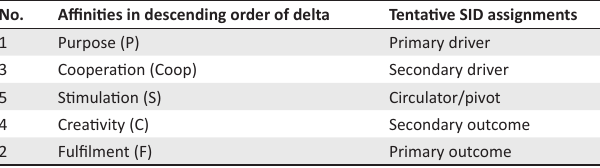
TABLE 3: Tentative system influence diagram